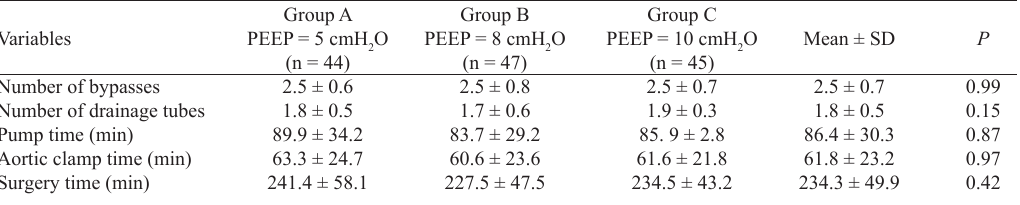
Table 2. Surgical data for patients undergoing CABG.